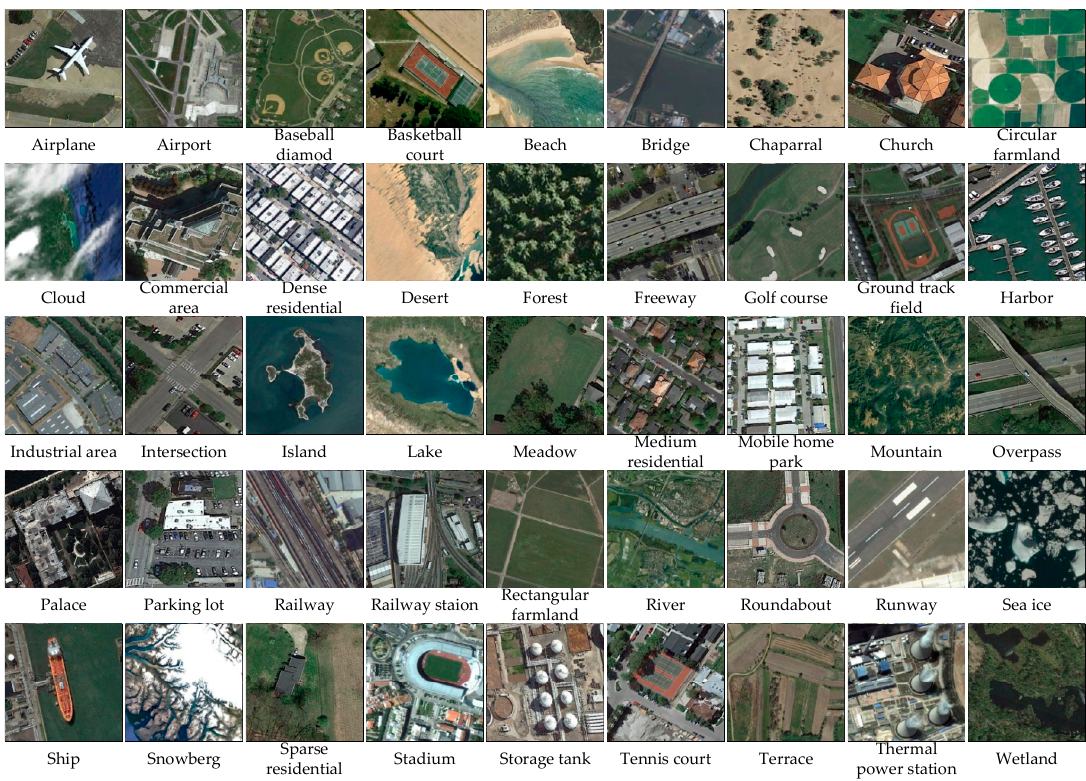
Figure 13. Sample images of each class in NWPU-RESISC45 dataset.